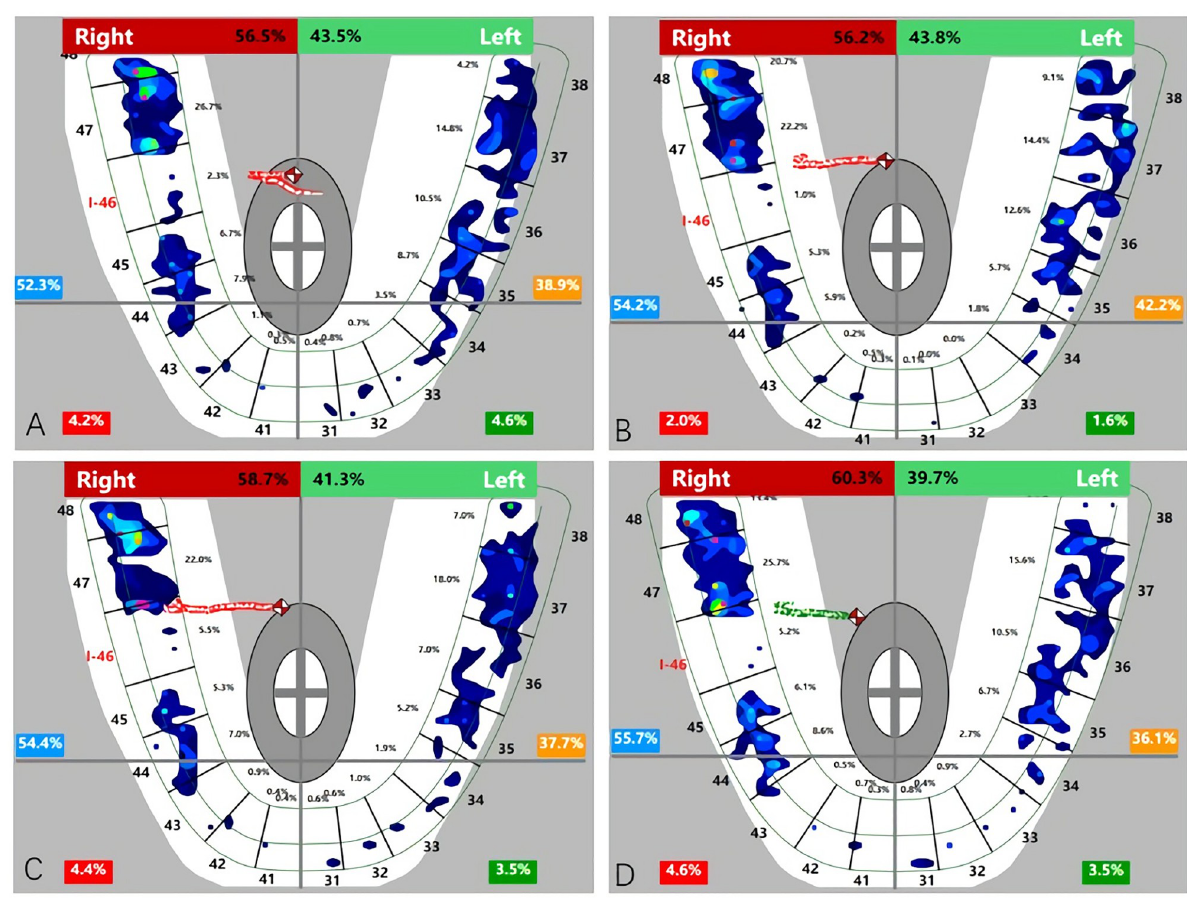
Fig 9. T-scan images of the bite force distribution on implant and teeth in different stages. (A) Post- 46 immediate insertion; (B) 2 weeks (final torque); (C) 3 months; (D) 6